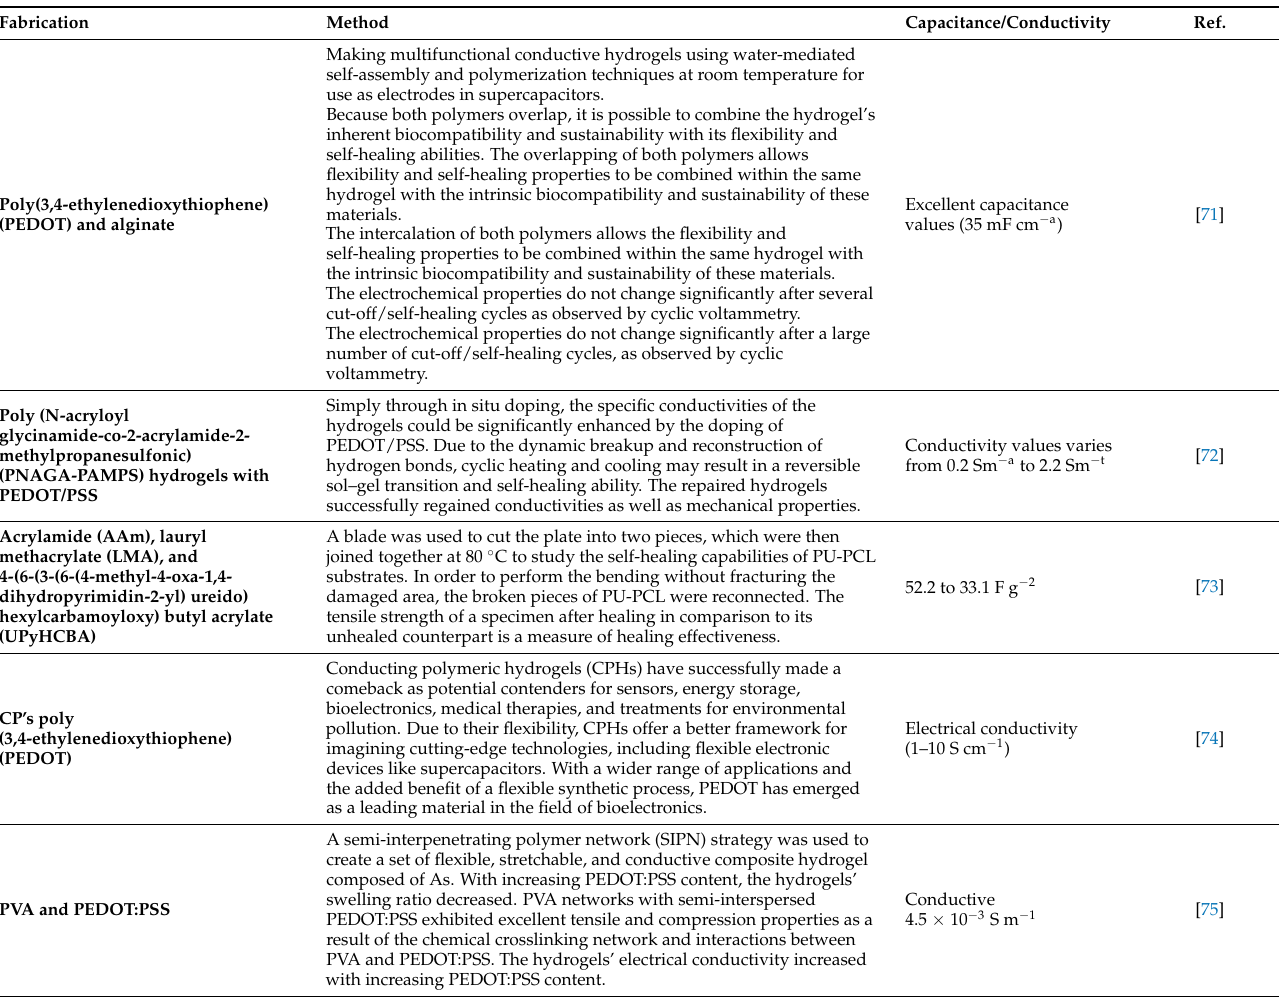
Table 3. Comparing the self-healing and high-electrification performance of supercapacitors with other devices in the